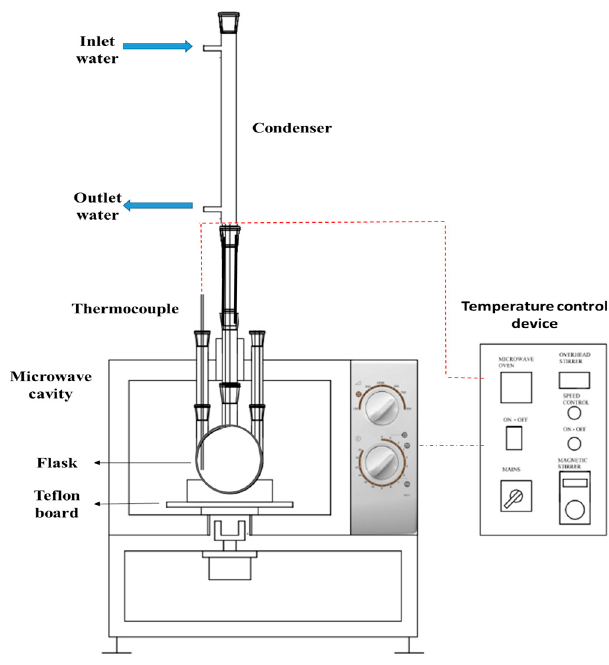
Figure 10. Schematic of the MAE system.